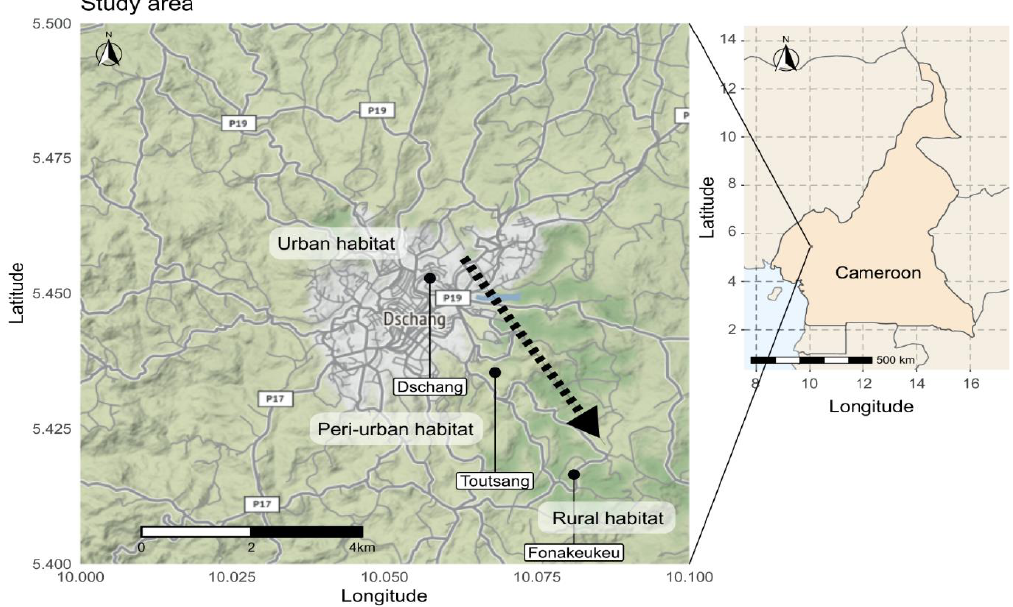
Figure 1. Map of collection sites in Dschang, West-Cameroon. Mosquito sampling was done in three habitats along a transect of urbanisation.